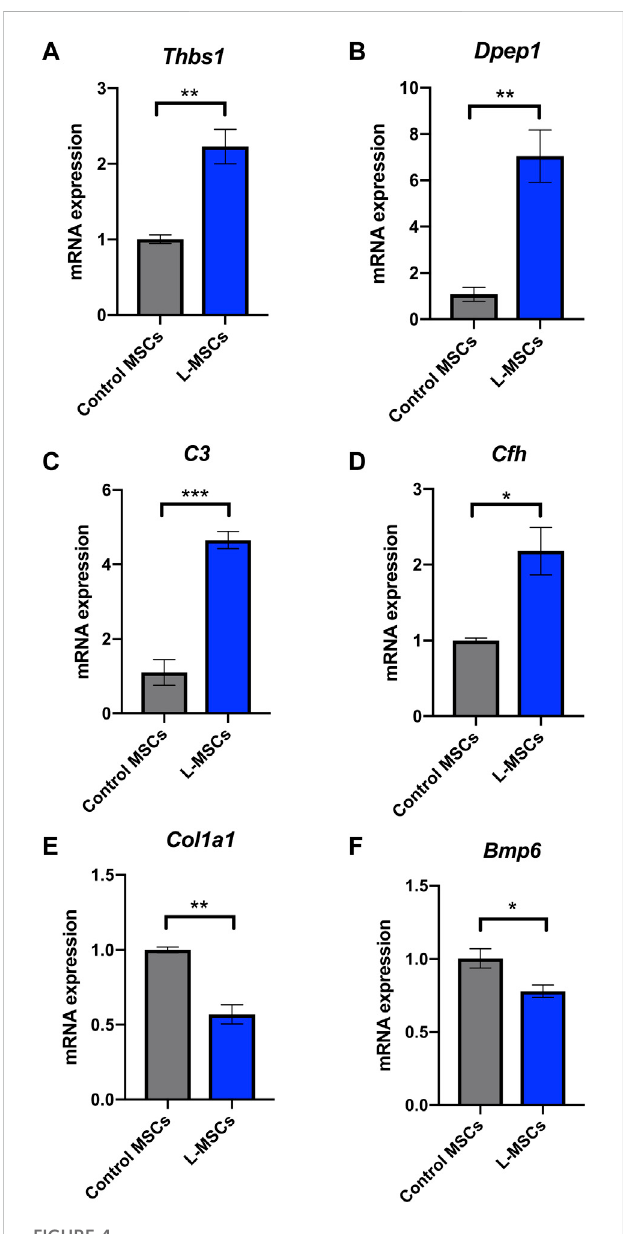
In fl ammatoryresponserelatedgenes Thbs1 , Dpep1 , C3 and Cfh are upregulated in L-MSCs while osteoblast differentiation related genes Col1a1 and Bmp6 are downregulated in L-MSCs. Mean expression of in fl ammatory response related genes (A) Thbs1 , (B) Dpep1 , (C) C3 and (D) Cfh in L-MSCs relative to that in control MSCs. Mean expression of osteoblast differentiation related genes (E) Col1a1 and (F) Bmp6